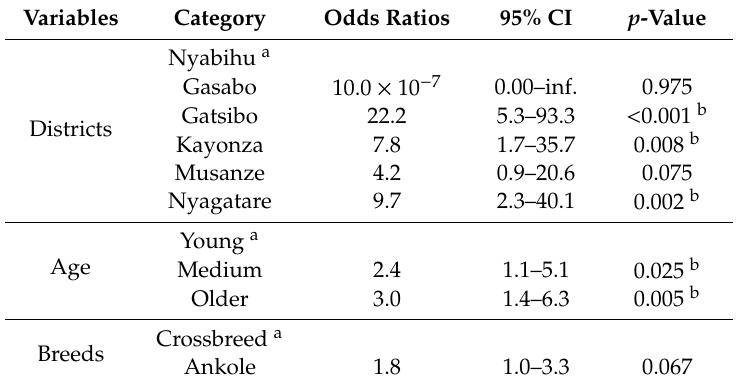
Table 2. Results of multivariable logistic regression between animal-level risk factors and serological status of brucellosis in cattle sampled at the wildlife-livestock-human interface in Rwanda.